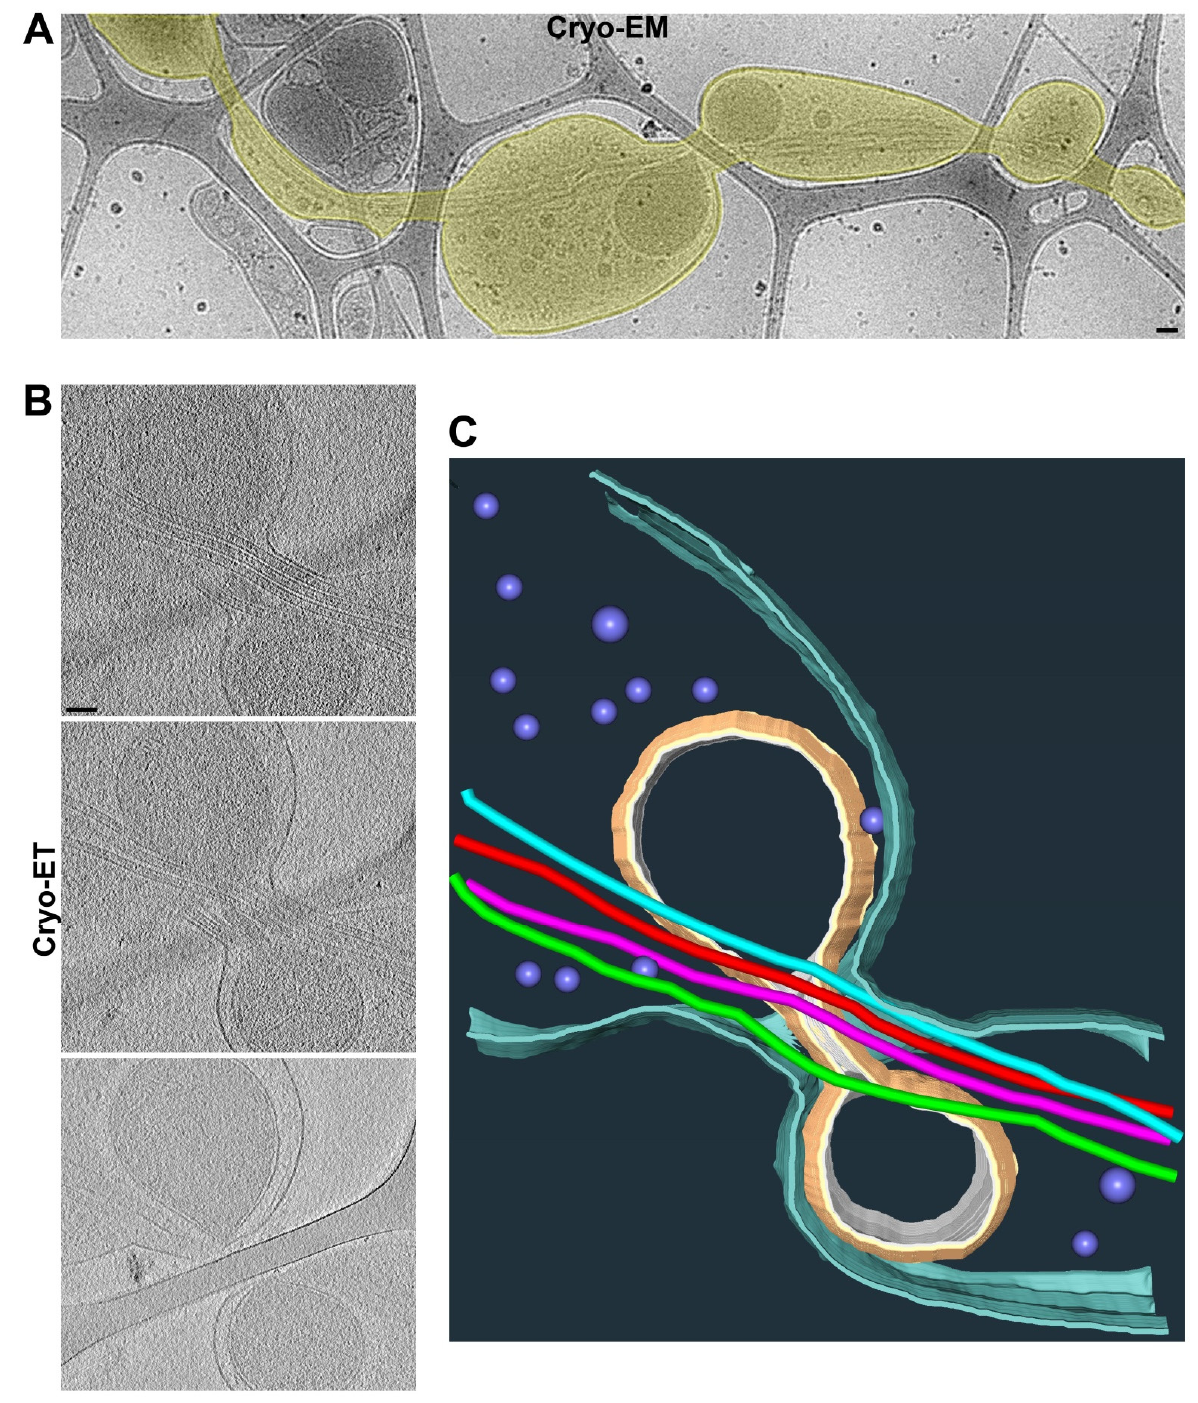
Figure 3. Two adjacent axonal varicosities with carbon fiber support in the middle. ( A ) Low- magnification view of an axonal segment with multiple varicosities growing on top of lacey carbon film. The axon is highlighted in yellow. ( B ) Three slices from the Cryo-ET tomogram of the junction of two axonal varicosities under high magnification. ( C ) Segmentation view of the varicosity junction in ( B ). Four MTs are represented as tubes of four different colors: mitochondria in yellow, plasma membrane in cyan, and small vesicles in purple. Scale bars, 100